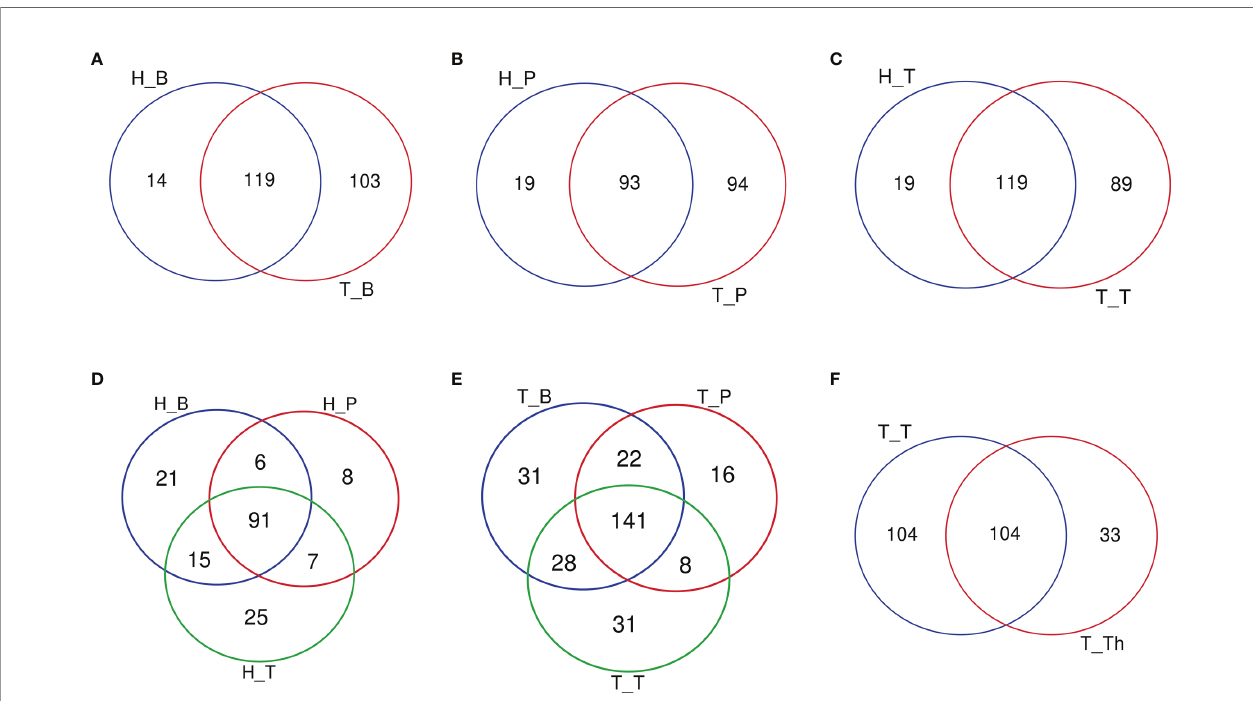
FIGURE 2 | Venn diagrams of the number of genera common/unique within different subgroups. (A) Salivary microbiota within the H_B and T_B subgroups. (B) Supragingival plaque microbiota within the H_P and T_P subgroups. (C) Tonsil surface microbiota within the H_T and T_T subgroups. (D) Microbiota of three niches in tonsil healthy participants. (E) Microbiota of three niches in tonsillar hypertrophy patients. (F) Microbiota within tonsil surface and parenchyma in tonsillar hypertrophy patients, which were the T_T and T_Th